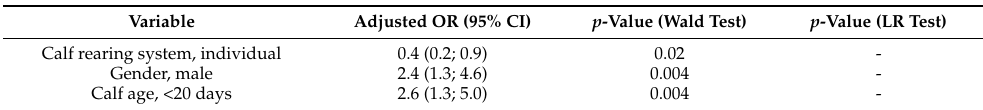
Table 3. Adjusted OD obtained by multiple logistic regression for the independent variable “RVA infection”. Log-likelihood = − 141.5; AIC = 291.0.